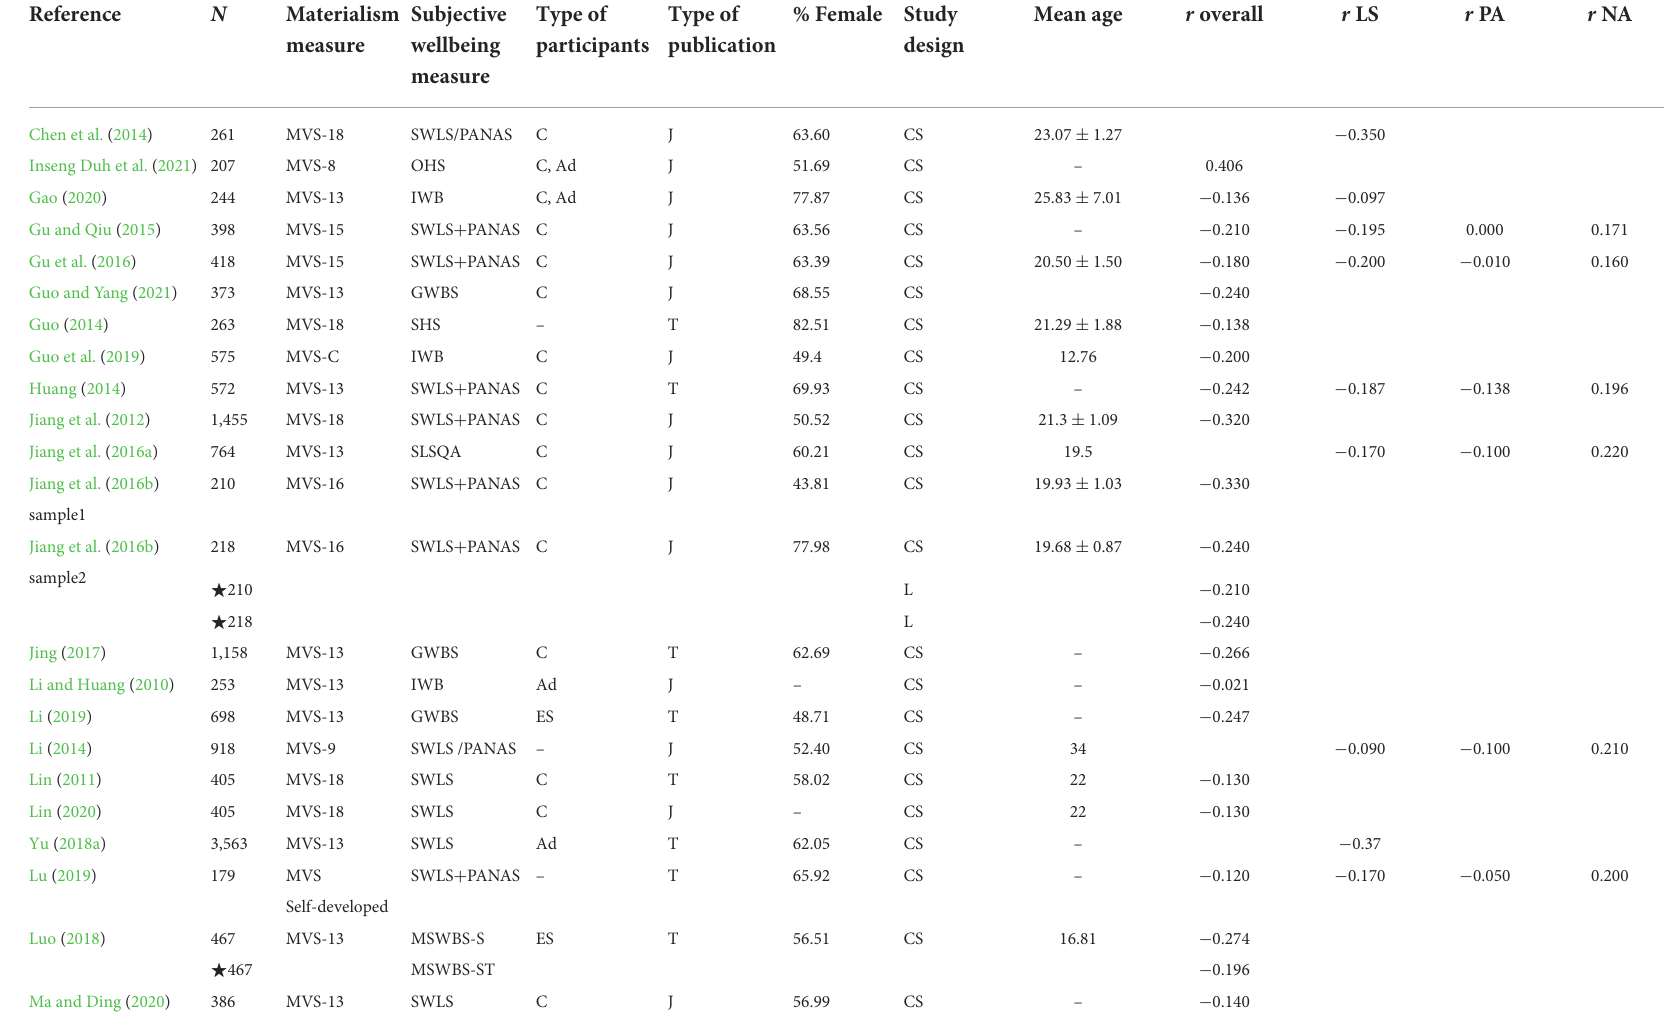
TABLE 1 A list of included